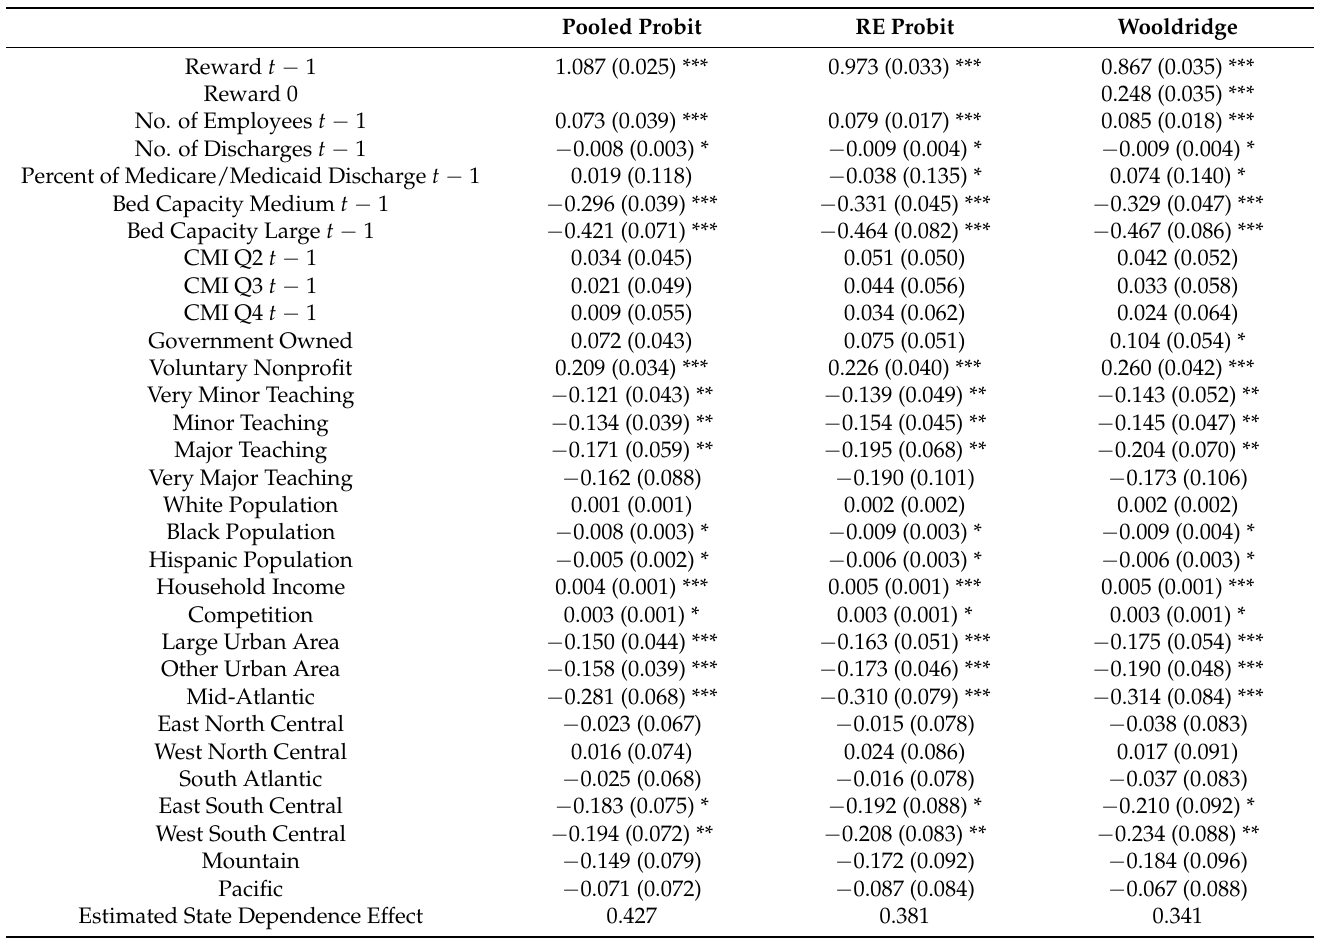
Table 6. Results of model estimates of state dependency. Pooled Probit RE Probit